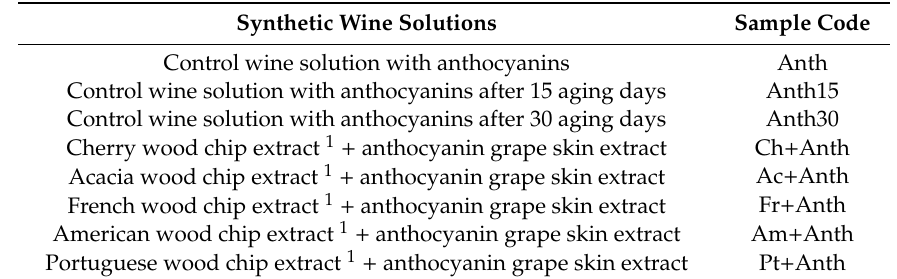
Table 1. Experimental red synthetic wine solutions with di ff erent combinations prepared in this